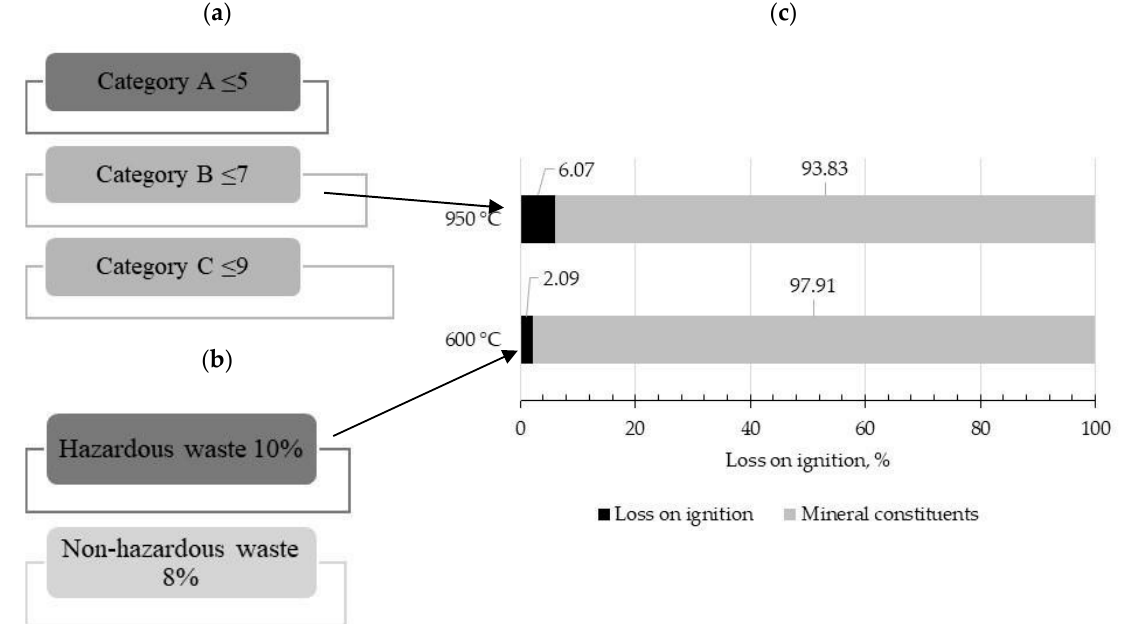
Table 1. Contents of oxides (%) in the tested fly ash.